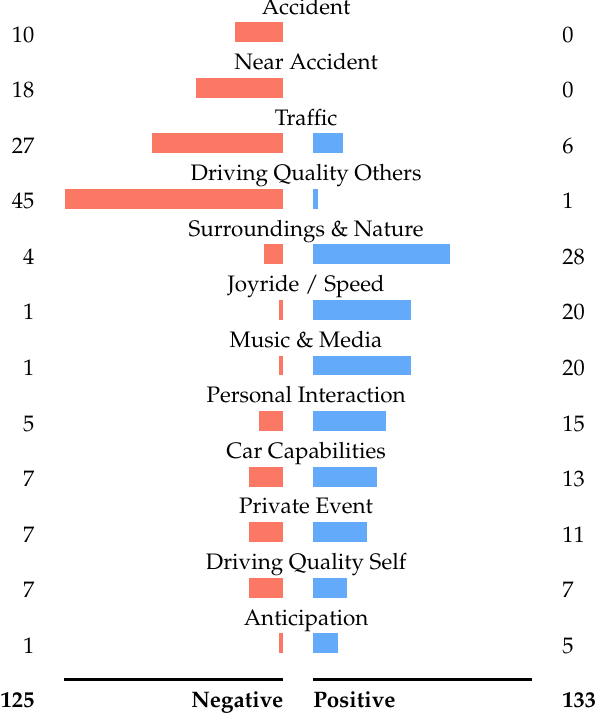
Figure 1. Negative experiences (red) were mostly triggered by traffic-related incidents, while positive situations (blue) are connected with nice surroundings, music, enjoyment of the ride and personal